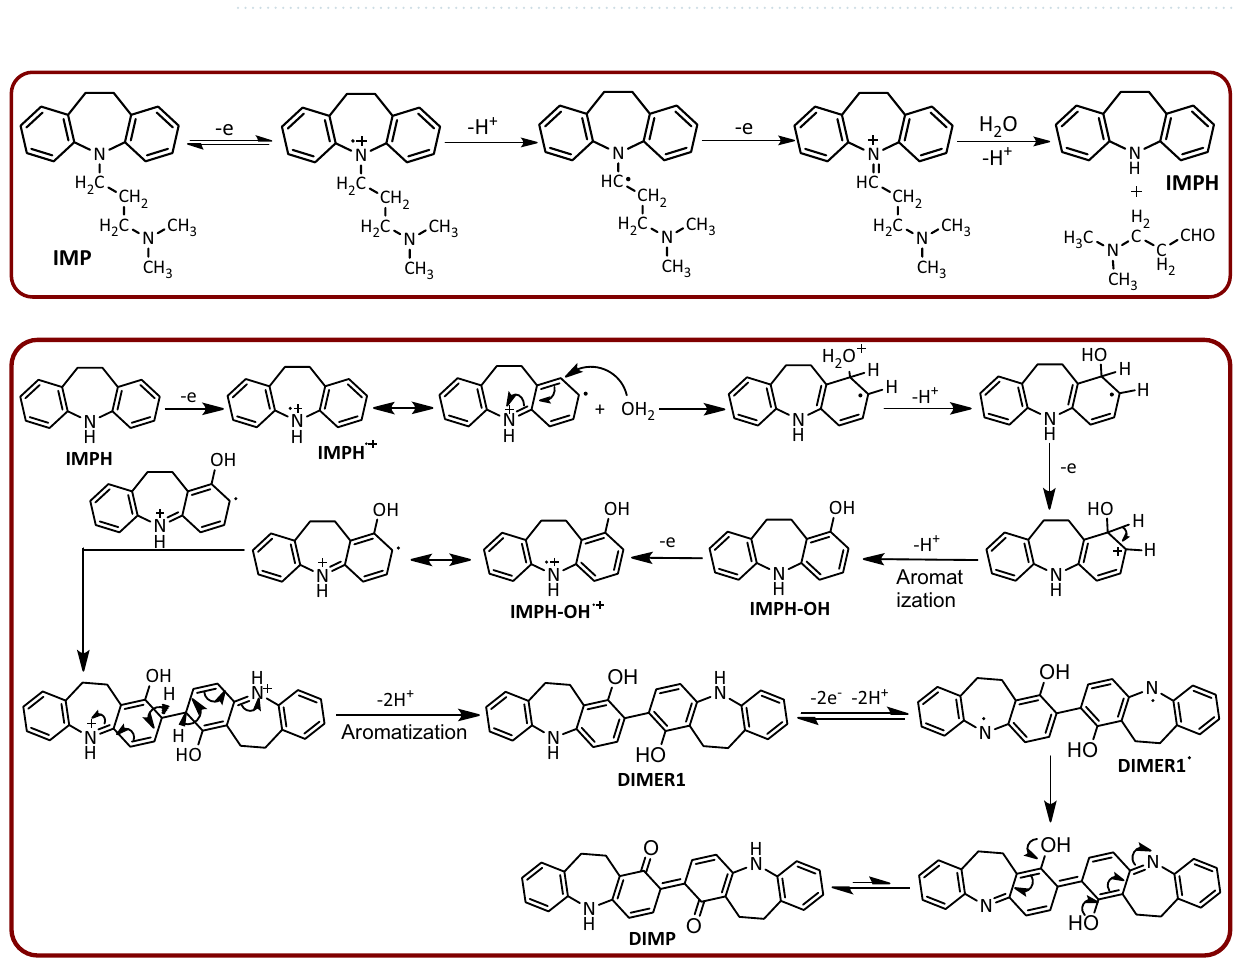
Figure 4. Electrochemical synthesis of DIMP by a domino dealkylation-oxidation-hydroxylation-dimerization- oxidation